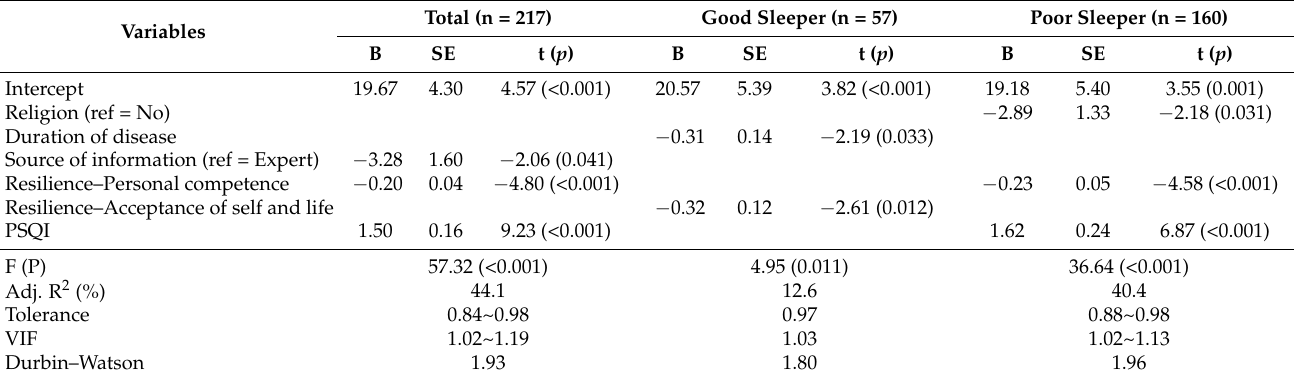
Table 5. Factors Influencing Depression (n =